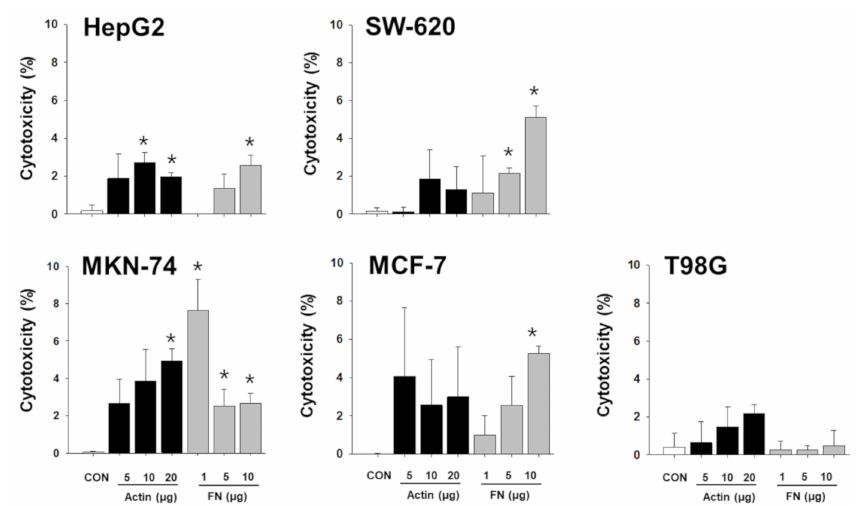
Figure 7. Cytotoxic e ff ect of recombinant β -actin and fibrinogen on di ff erent types of cancer cells. Varying concentrations of recombinant β -actin and fibrinogen were applied to 5 di ff erent types of cancer cells, and cytotoxicity on cancer cells was measured. Experiments were performed in triplicate. Significant di ff erences were determined via ANOVA, with p -values indicated as * p < 0.05 compared to untreated control (CON). Actin: β -actin, FN: